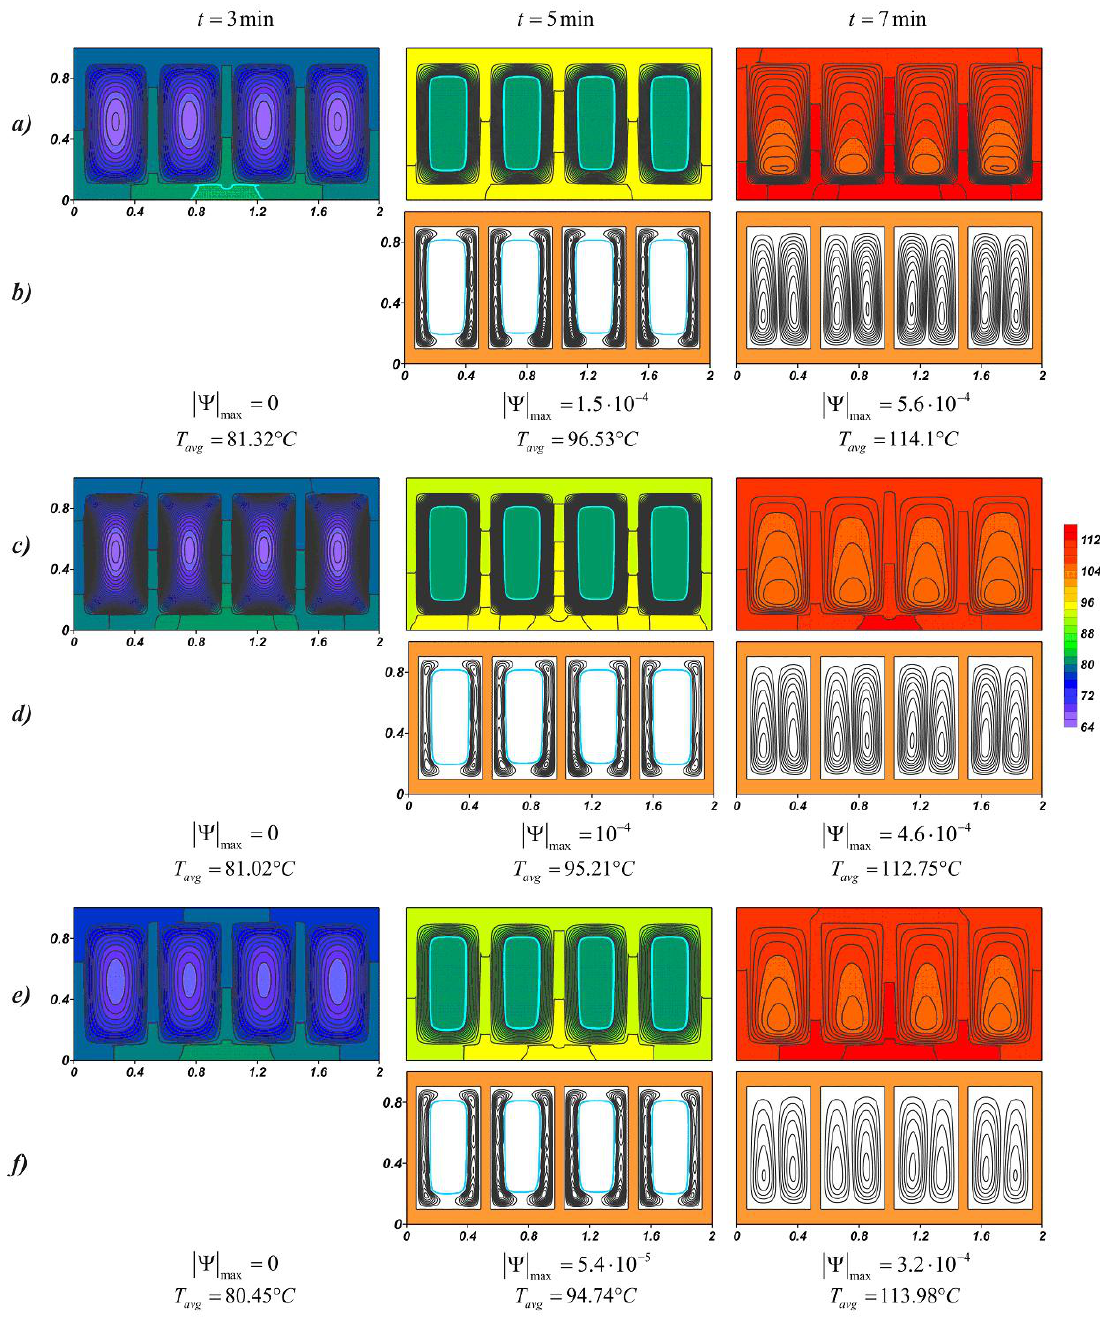
Figure 9. Temperature fields and streamlines for RT-80 at different time moments: ( a , b ) Φ = 0%; ( c , d ) Φ = 2%; ( e , f ) Φ = 6%.